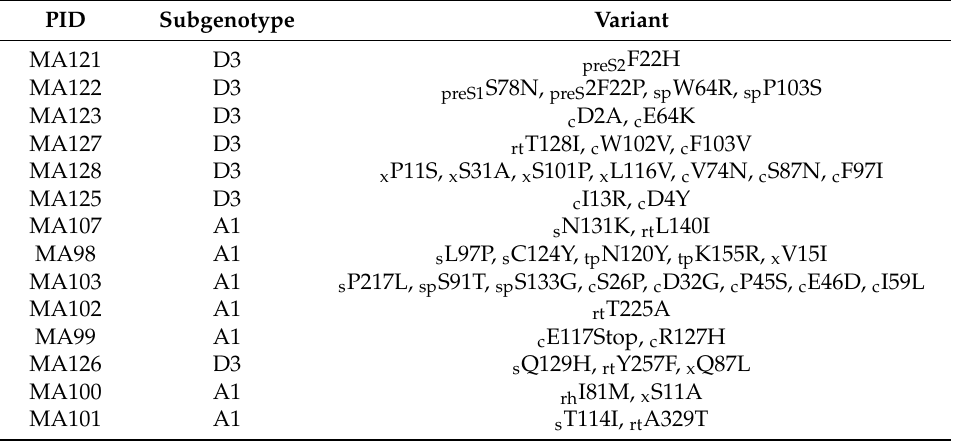
Table 5. OBI unique mutations in different